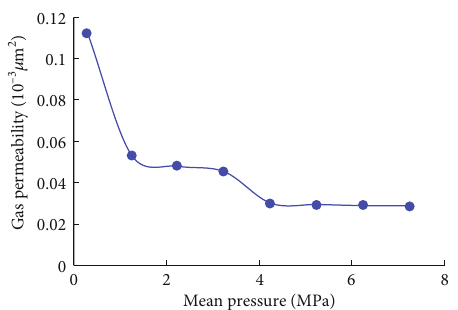
Figure 3: Change of gas permeability with test pressure.